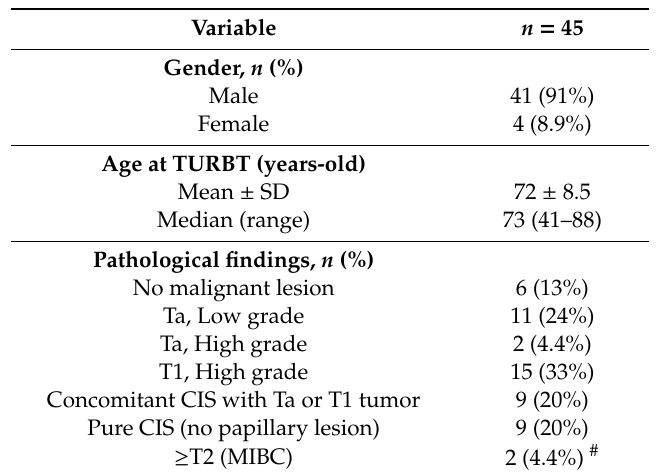
Table 1. Clinicopathologic variables of 45 patients undergoing ALA-PDD-TURBT for suspected NMIBC.